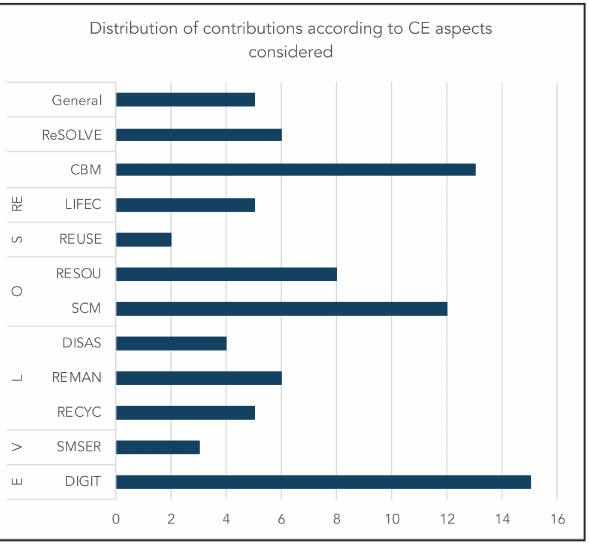
Figure 8. Distribution of the reviewed contributions according to CE aspects considered.